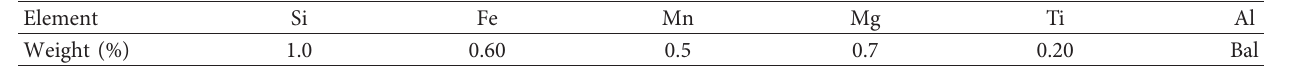
Table 1: Chemical constituents of AA6082 aluminum.